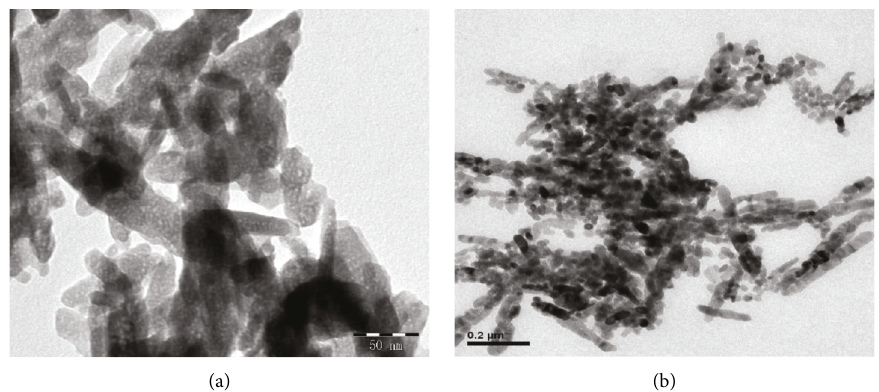
Figure 2: TEM images of (a) HA nanoparticles and (b) SS nanoparticles.